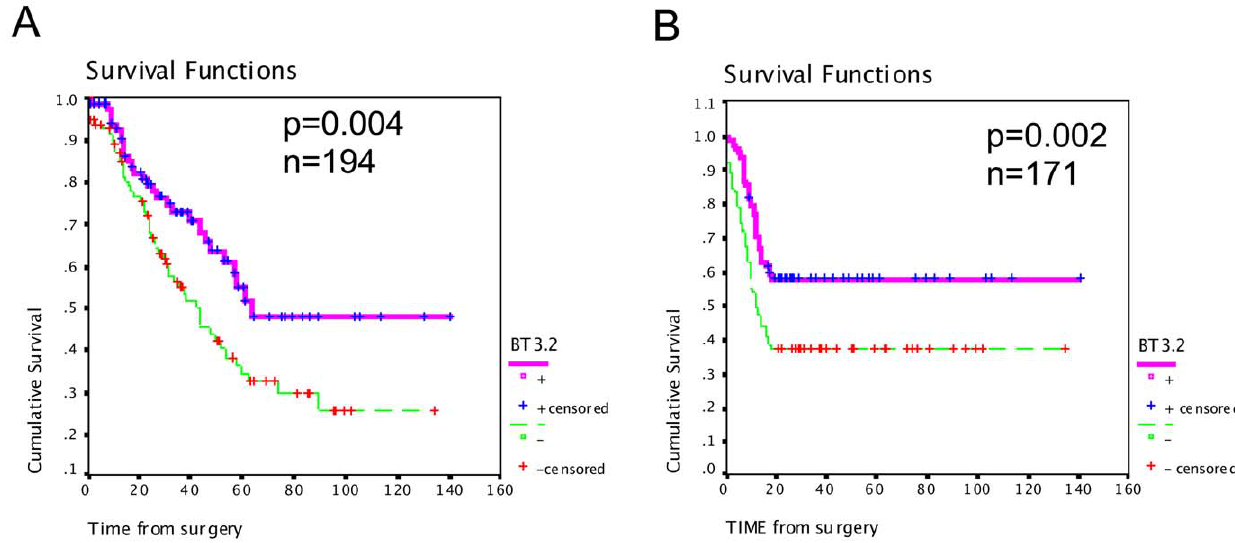
Figure 2. Kaplan Meier analysis of BT3.2 in high-grade serous EOC. Kaplan-Meier curves of overall survival (A) and disease-free survival (B) in 194 and 171 patients, respectively. Significance (p) is indicated by log